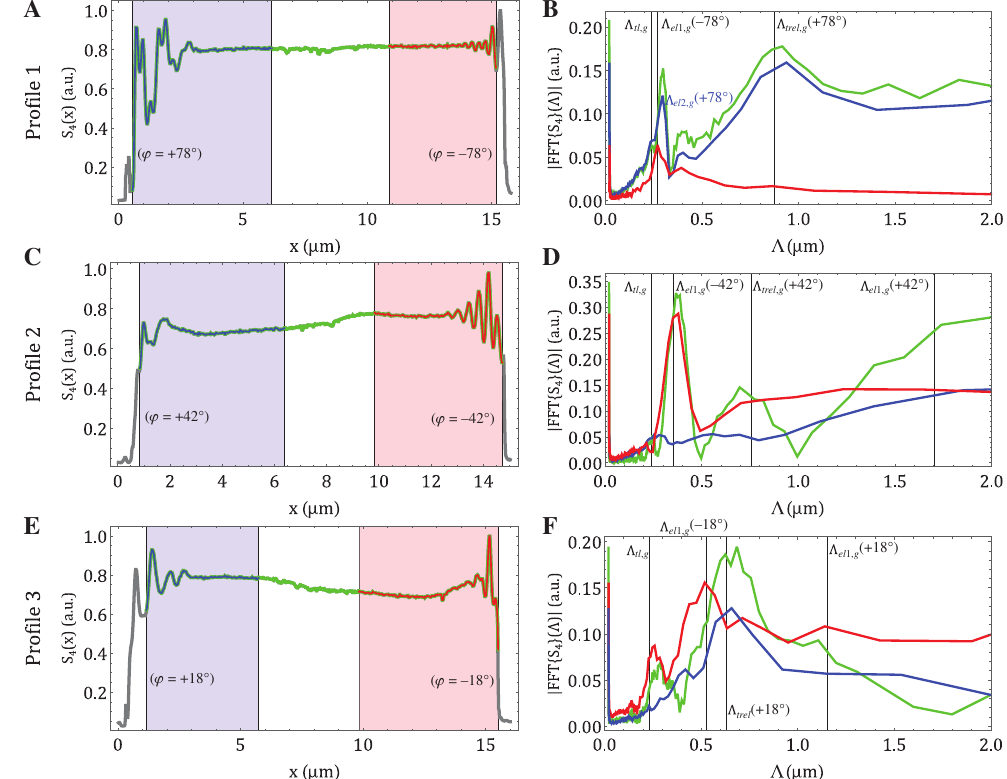
Figure 7: Profiles and corresponding FFTs from the s-SNOM scan at 521 nm shown in Figure 6B. (A) profile 1, (B) corresponding FFT, (C) profile 2, (D) corresponding FFT, (E) profile 3 and (F) corresponding